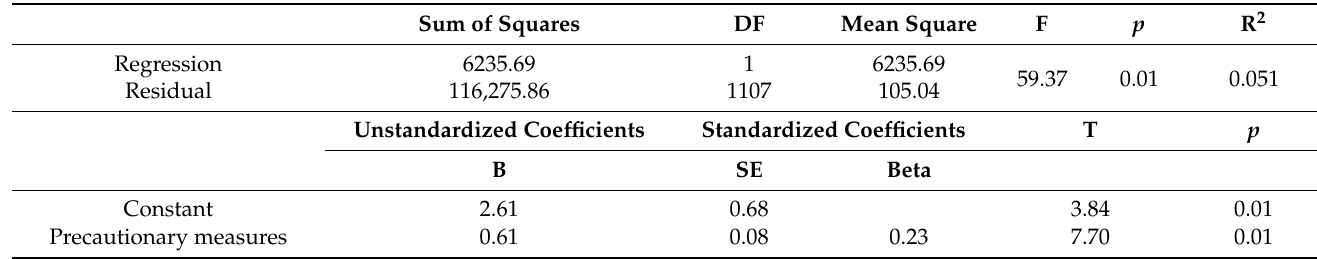
Table 6. Regression analysis between the total scores of precautionary measures and CES-D